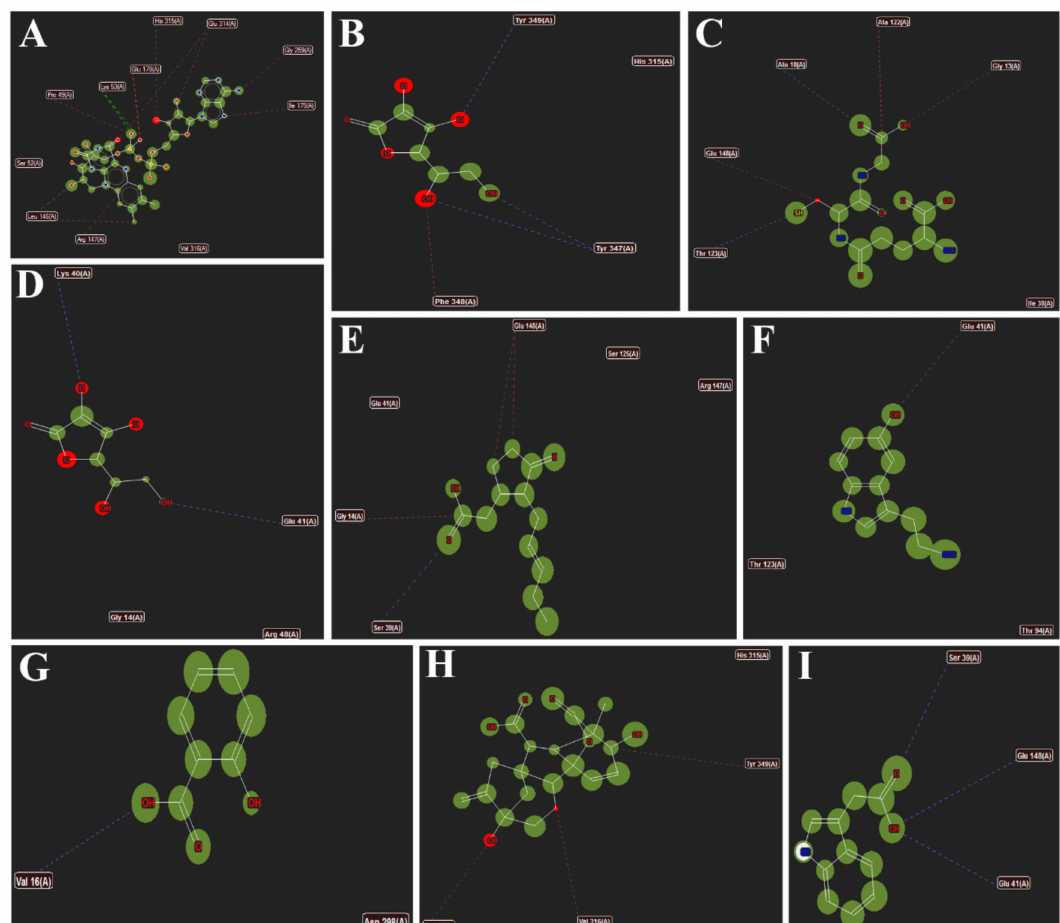
Figure 8. Interactions of different metabolites ( A ) Co-crystallized FAD; ( B ) MDHA; ( C ) GSH; ( D ) AsA; ( E ) JA; ( F ) 5-HT; ( G ) SA; ( H ) GA3 and ( I ) IAA with the active site amino acid